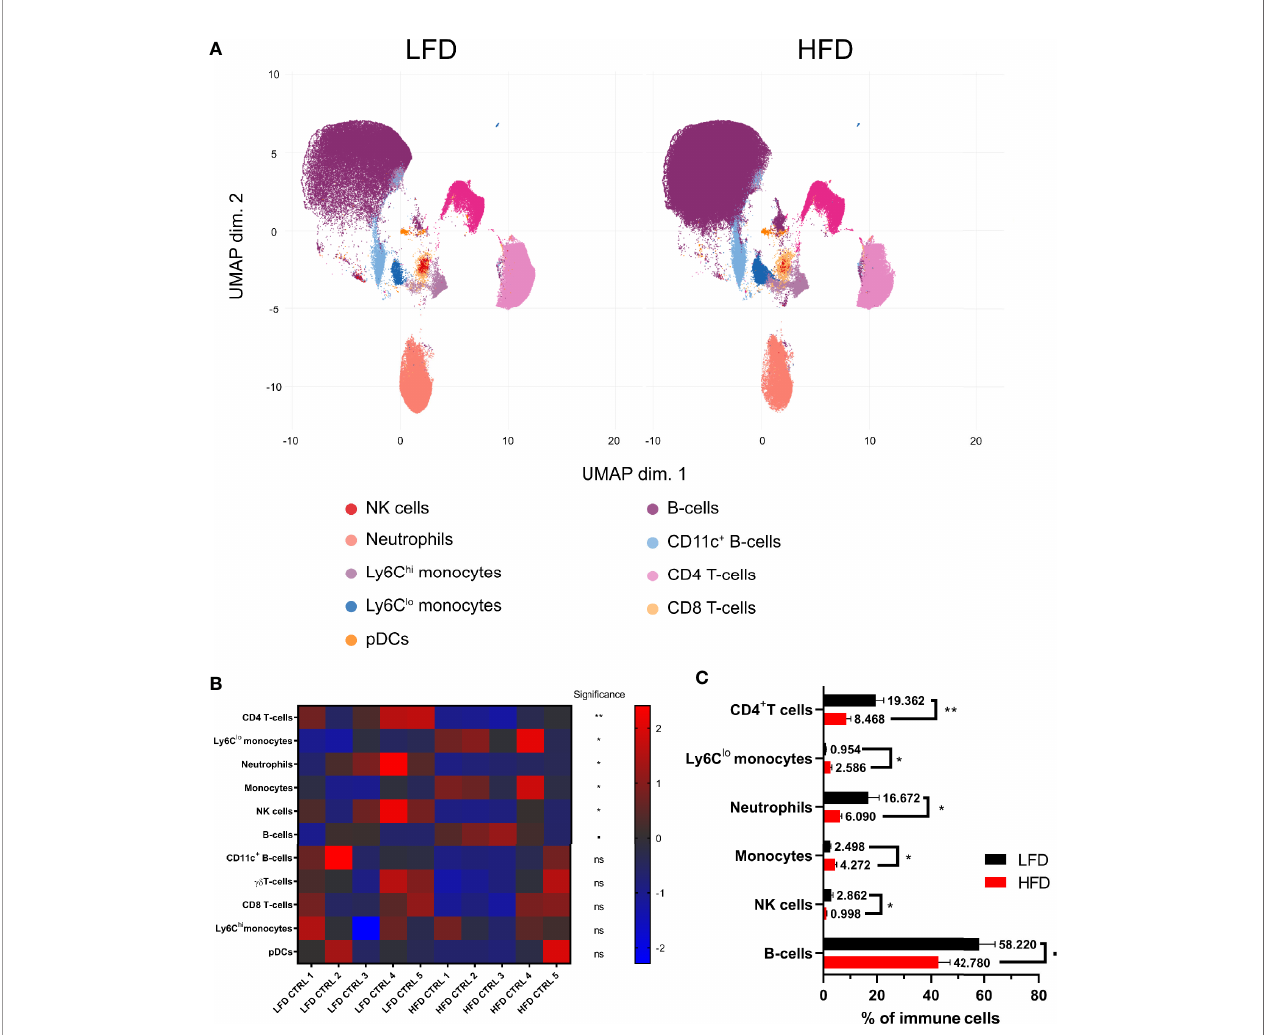
FIGURE 1 | In fl uence of diet-induced obesity on circulating murine immune cells. Uniform manifold approximation and projection (UMAP) with clusters from FlowSOM analysis (Ly6G, CD115, CD4, CD11b, CD19, CD3e, TCRgd, Ly6C, NKp46, CD8a, NK1.1, B220, and CD11c) in mice receiving either low-fat diet (LFD) or high-fat diet (HFD) (A) . Z -score normalized heatmap indicating percentages of immune cell populations in lean and obese mice (B) as well as their actual percentages (C) . Statistics: unpaired two-tailed Student ’ s t -test to compare the populations between lean and obese mice. ▪ indicates p ≤ 0.1, * indicates p ≤ 0.05, ** indicates p ≤ 0.01. Sample sizes: LFD CTRL = 5, HFD CTRL = 5. Data are displayed as mean ± SEM. ns, not signi fi